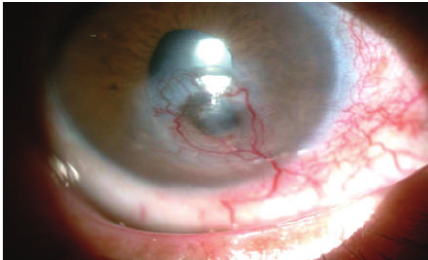
Figure 5: No response after three injections of bevacizumab.